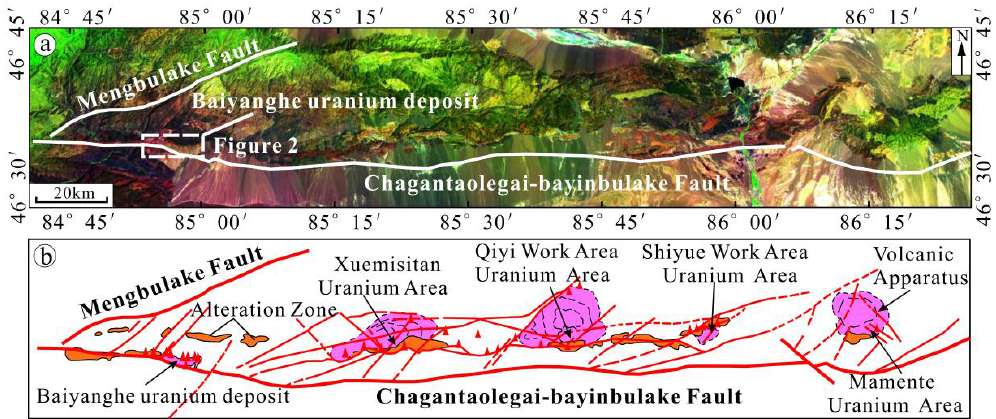
Figure 1. ( a ) LANDSAT 7 ETM+ pseudo-color image (Red: band 7, Green: band 4 and Blue: band 2) of the eastern Xuemisitan area and the Baiyanghe uranium deposit’s location (image produced by stretching). The green areas represent vegetation, the mauve areas represent the Neogene sedimentary strata, and the black areas in the left of the image represent Carboniferous strata. ( b ) Interpreted image of the uranium ore volcanic deposit’s distribution in the eastern Xuemisitan area (modified from